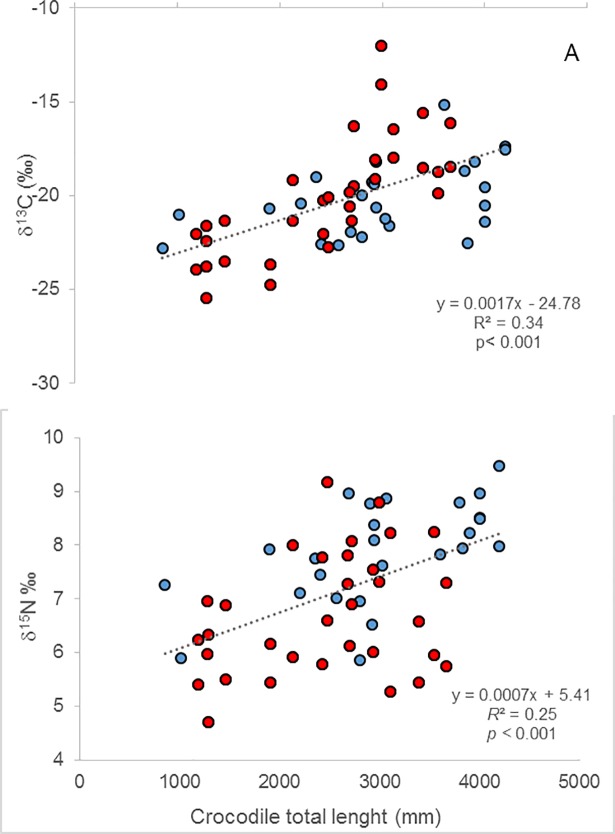
Correlation between isotopic value of crocodile scute (δ13C and δ15N; ‰) and body size (mm).Red circles are values from this study, blue circles are values from C. porosus in Cape York, Australia, from Hanson et al. 2015 [7]. Both datasets follow a linear trend of higher isotope values with increasing total body length (mm).